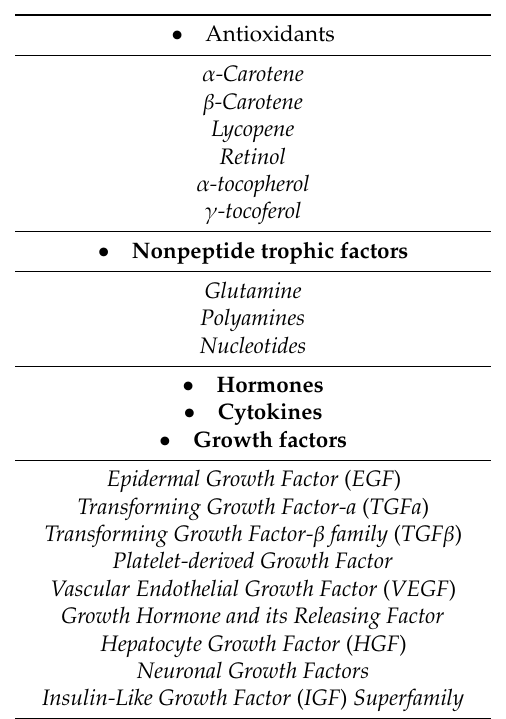
Table 1. Trophic and bioactive factors in colostrum and